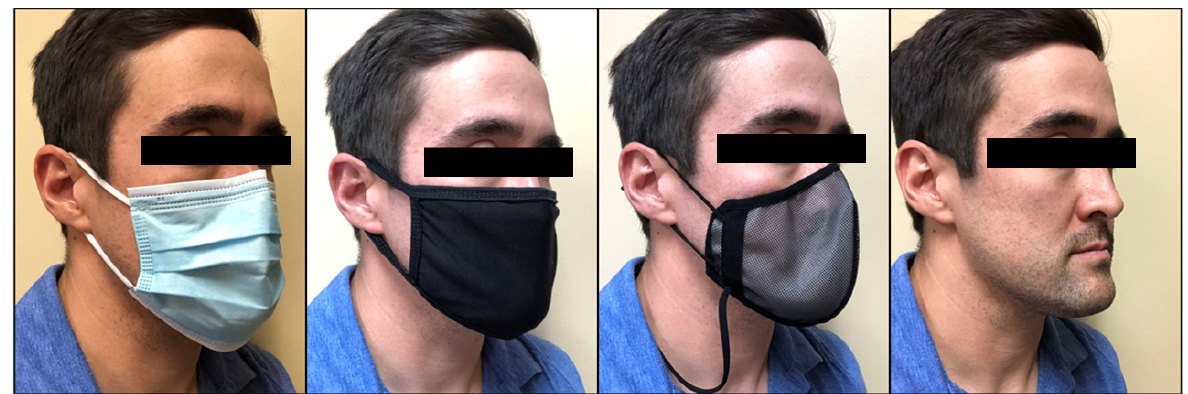
Figure 1. Facial coverings worn during the anaerobic exercise bouts (surgical, fabric, SHEMA97, and no mask condition).